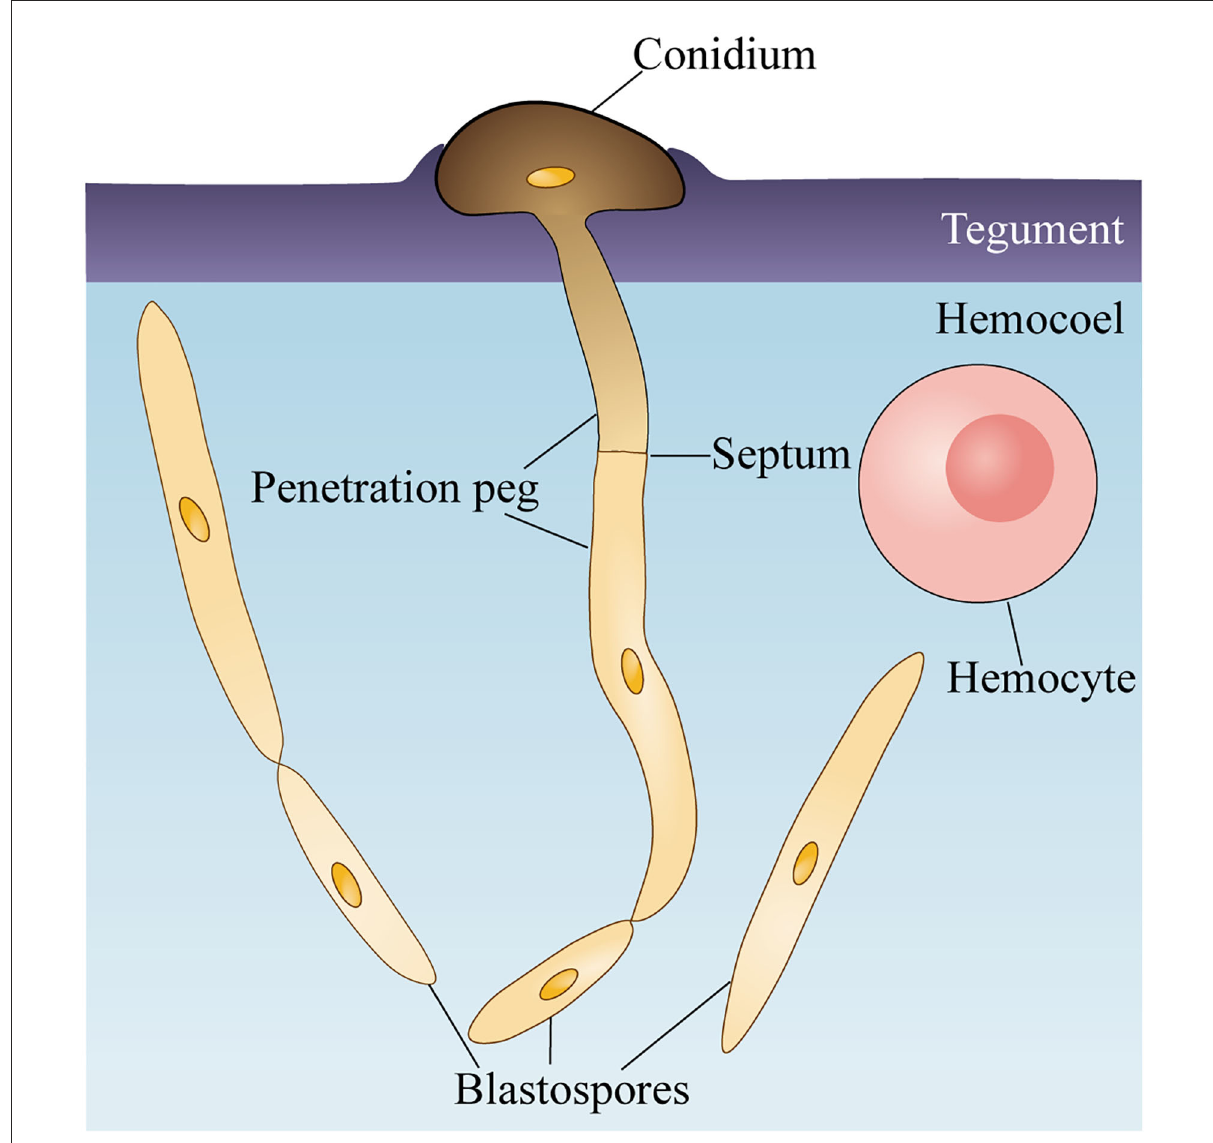
FIGURE5 Schematic of Ophiocordyceps sinensis conidium invading Thitarodes xiaojinensis larvae. O. sinensis conidium attaches and degrades the teguments of T. xiaojinensis larvae. Germinated conidium directly produces a penetration peg to enter the hemocoel. After reaching T. xiaojinensis larvae hemocoels, the penetration peg generates a blastospore and proliferates in a yeast-type propagation